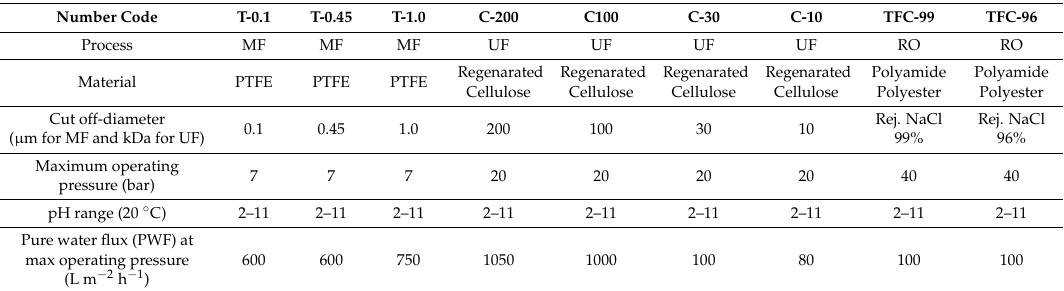
Table 1. Major physico-chemical properties of the nine membranes examined in the present study, as indicated by the manufacturer of the vibratory shear-enhanced process (VSEP) treatment system (New Logic International, Concord,